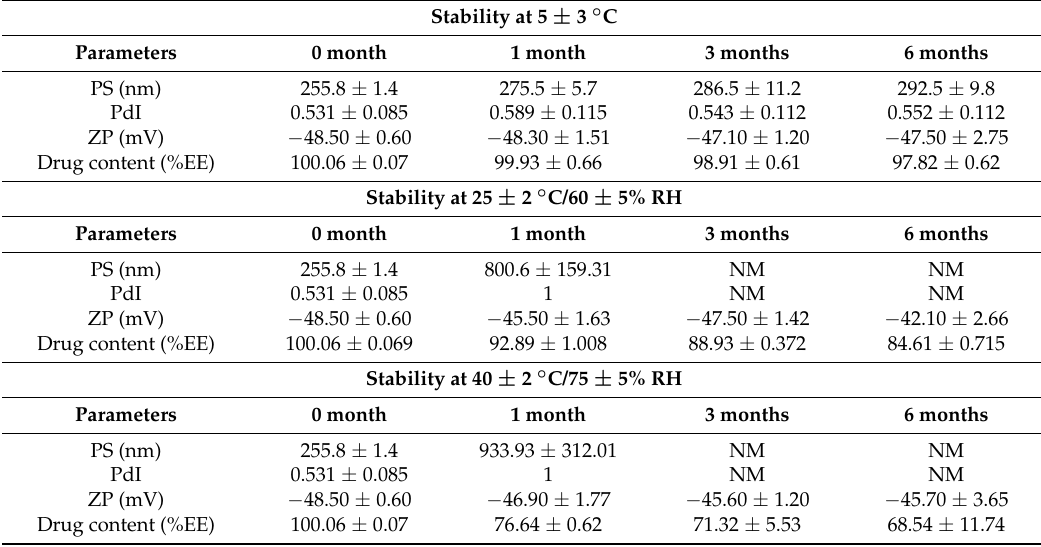
Table 7. The stability of optimized LPV-NLCs-7-Tres formulation stored at 5 ± 3 ◦ C, 25 ± 2 ◦ C/60